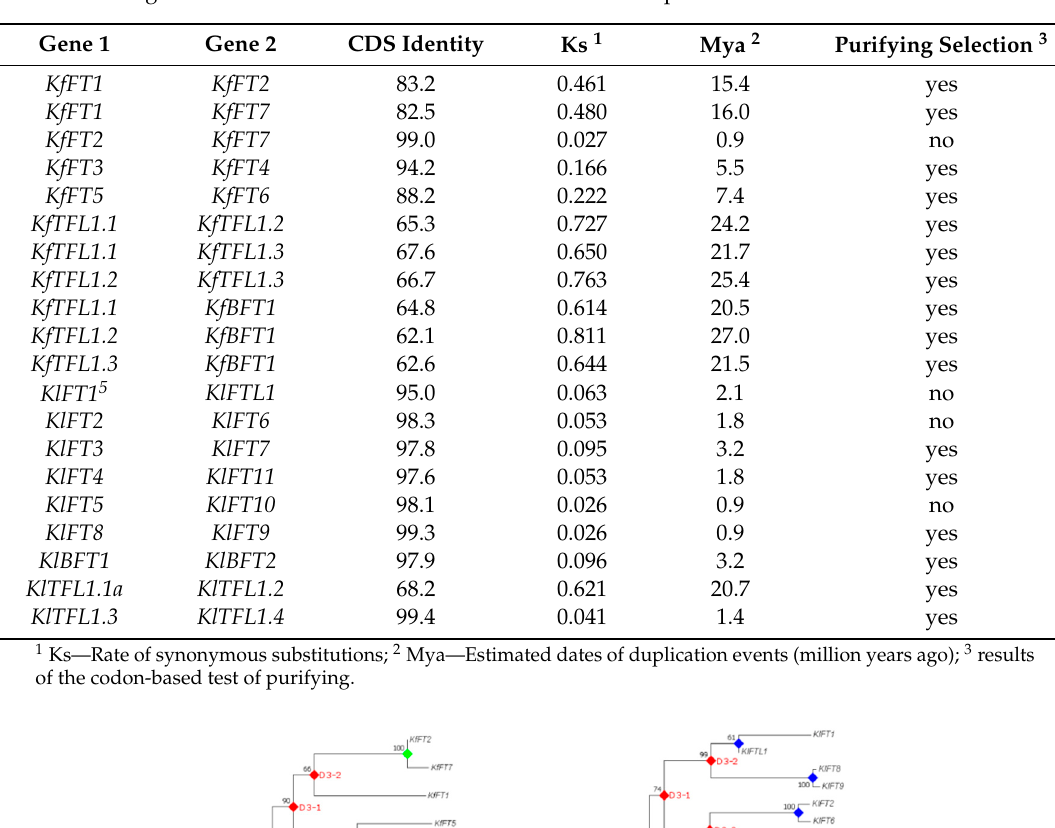
Table 2. The Ks values and estimated absolute dates for the duplication events between the duplicated Kalanchoë genes associated with terminal branches in the tree species clades.